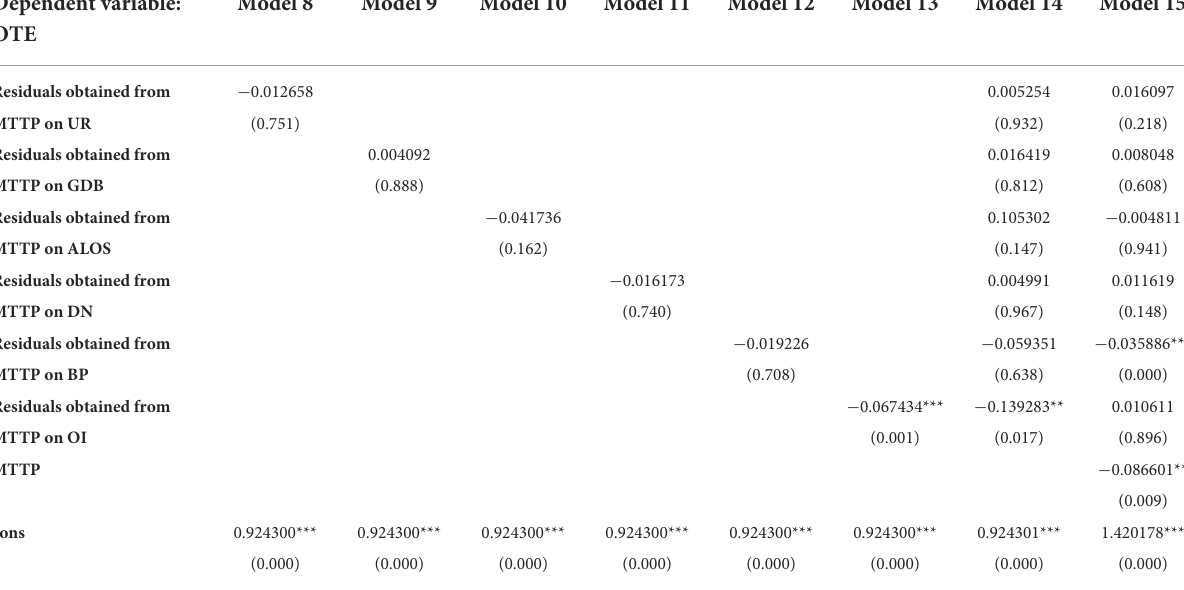
TABLE 12 Results of bootstrapping truncated regression for PHCs: estimations of the residuals from MTTP.